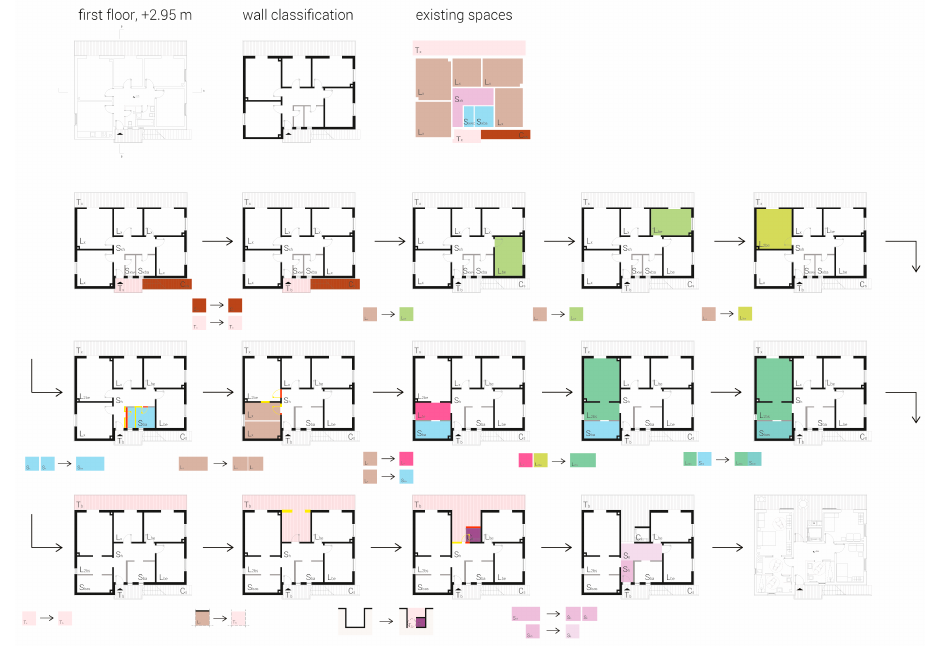
Figure 8. Cataloguing all the transformations in order to infer the transformation rules (one of the working versions) (Ana Bel č i č , 2022).